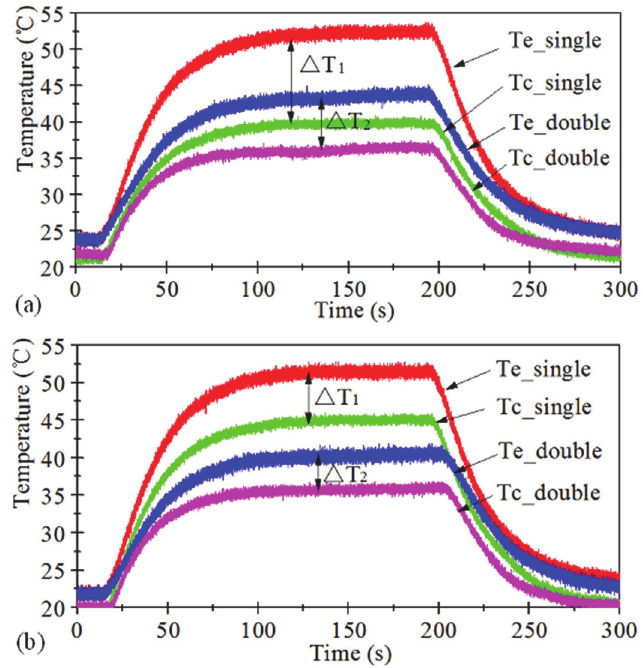
Figure 8. Temperature outside the evaporator and condenser for heat sinks placed at ( a ) 0° and ( b ) 90°.